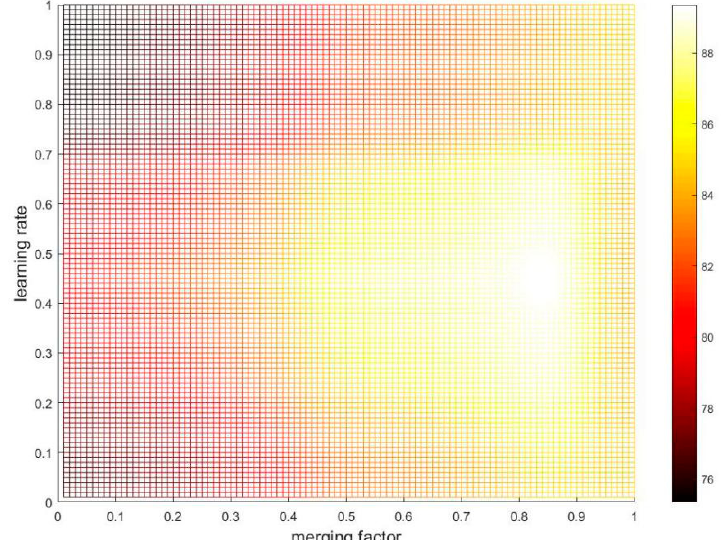
Figure 5. The results of the parameter setting experiments on OTB-2013 benchmark. The color bar denotes the one pass evaluation (OPE) accuracy percent (%) of location error threshold (LET) at 20 pixels. The horizontal and vertical coordinates represent merging factor α and learning rate η t 2 respectively. The points ranging from (0.1, 0.1), (0.1, 0.2), …, (1.0, 1.0) were obtained in experiments, others were obtained by the linear interpolation method. When the point 2 the OPE accuracy is maximized. Table 1. The parameter settings of the proposed PCF tracker.